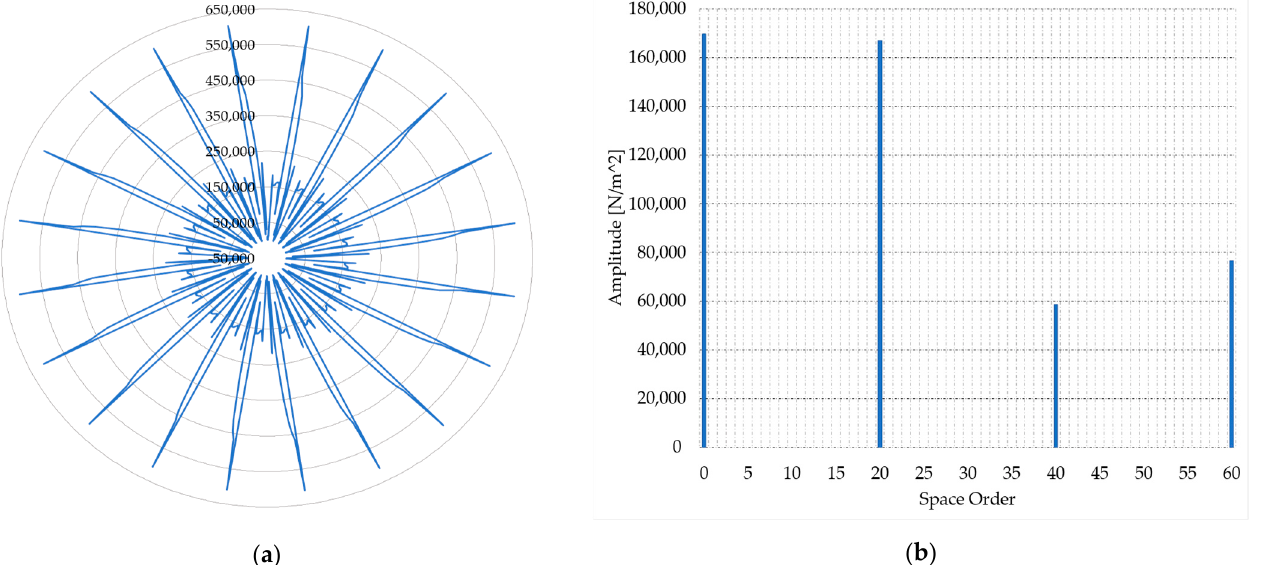
Figure 5. ( a ) Force space distribution and ( b ) force harmonic analysis of the motor.